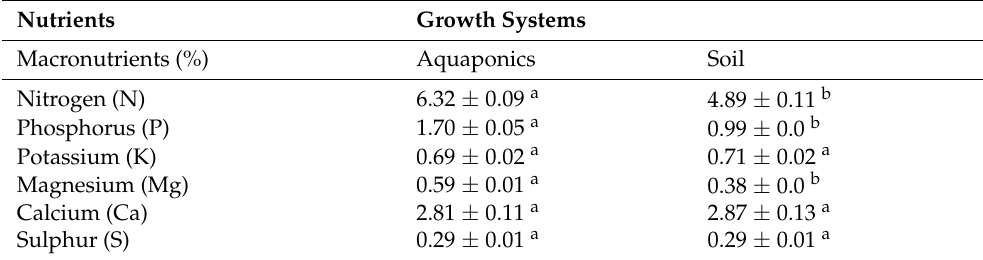
Table 3. Macronutrients (%) and micronutrients (mg kg − 1 ) in basil leaves under soilless (aquaponic) and soil systems at 70